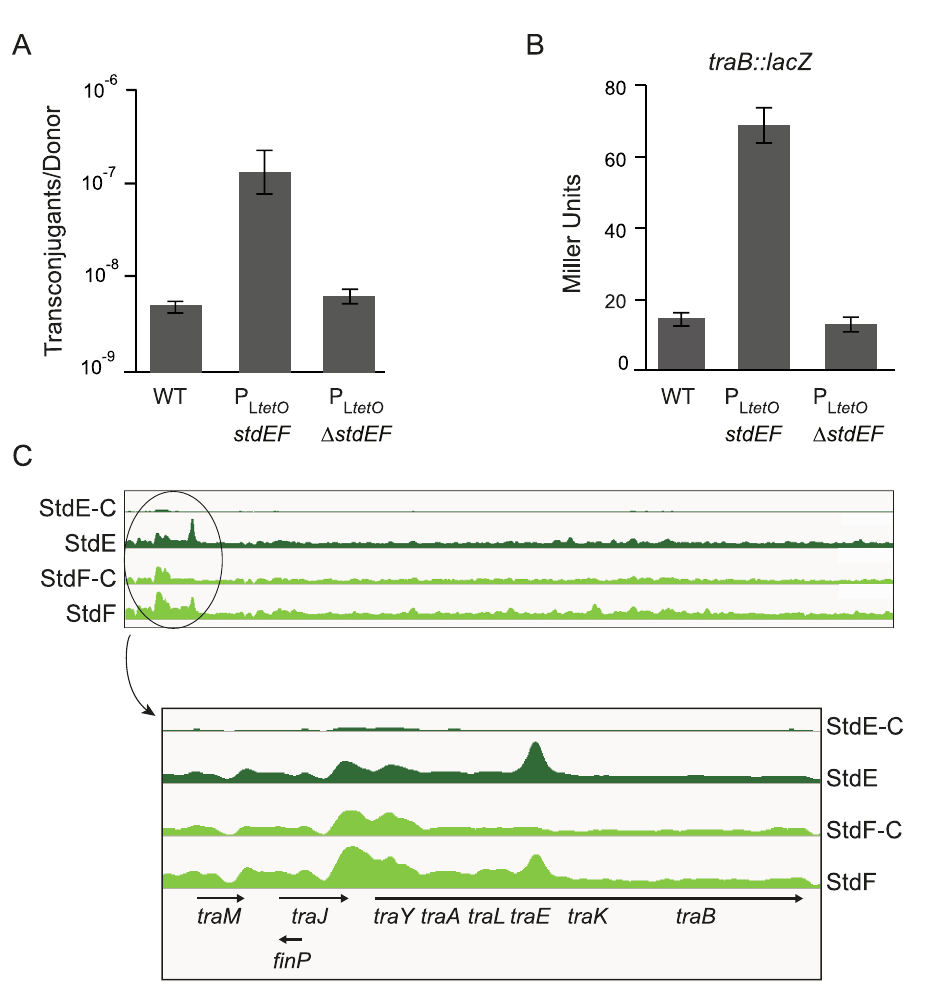
Fig 6. Regulation of conjugal transfer by StdE. A. Conjugal transfer of the virulence plasmid. Donors were the wild type strain, P L - stdEF spvA (SV7554) and P L - Δ stdEFspvA (SV7555). The recipient was trg :: mudQ pSLT - (SV4938) tetO tetO in all matings. Values are averages and standard deviations from 3 independent experiments. B. β -galactosidase activity of a traB :: lacZ fusion in strains traB :: lacZ (SV7551), P L - stdEF traB :: lacZ (SV7550), and P L - Δ stdEFtraB :: tetO tetO lacZ (SV7549). C. ChIP-seq data for the tra operon of the virulence plasmid. In the lower part of the figure, the promoter-proximal tra region is enlarged. StdE-C and StdF-C indicate binding peaks found for the mock IP-sample.